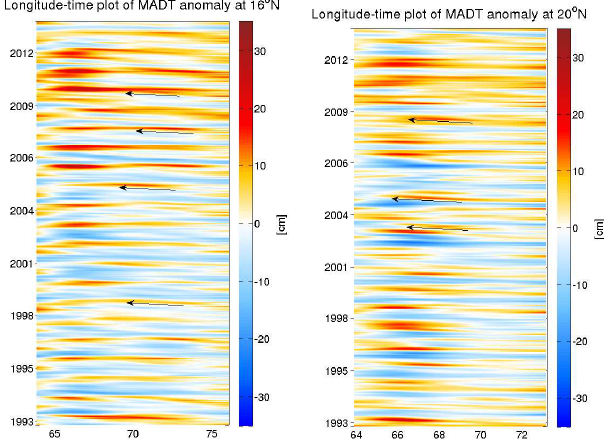
Figure 11. Hovmoller diagram in longitude vs. time for the MADT anomaly from AVISO at 16 ◦ N (left) and 20 ◦ N (right).